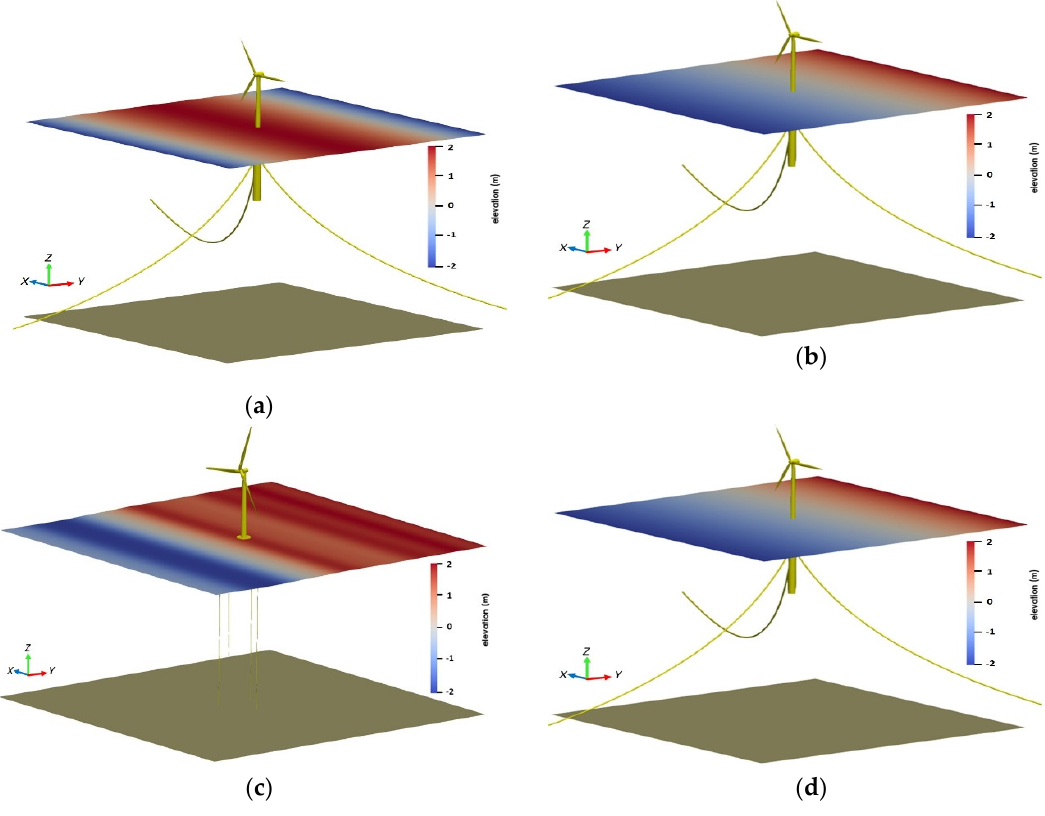
Figure 6. Snapshots of the unidirectional irregular waves interacting with ( a ) OC3-Hywind spar; ( b ) UMaine-Hywind spar; ( c ) MIT/NREL TLP; and ( d ) UMaine TLP.